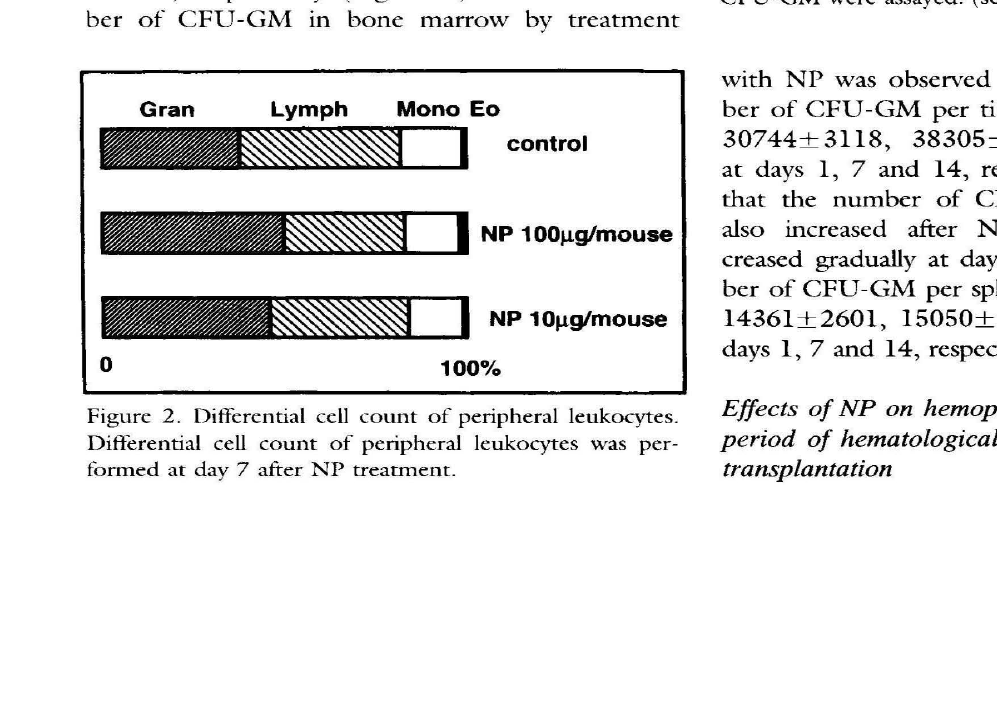
Figure 4. The number of CFU-GM in the spleen after NP treatment. Spleen cells were obtained 1, 7 and 14 days after NP treatment and changes in the number of CFU-GM were assayed. (see Fig. 3)